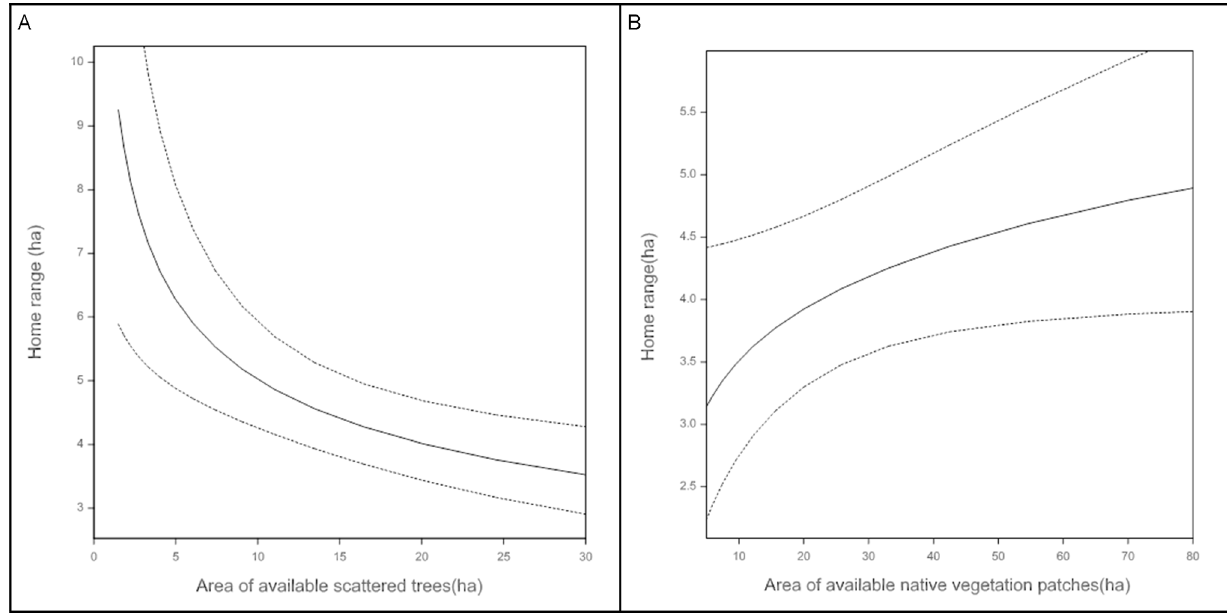
Figure 5. Influence of available area of three countryside elements on squirrel glider home range size. Panel (a) scattered trees, Panel (b) native vegetation patches. Based on 95% of fixes and associated 95% confidence intervals.